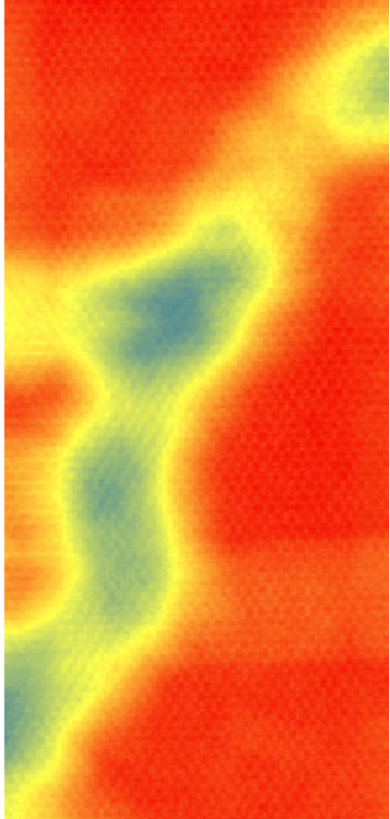
Figure 8: Tree density in trees/hectare (red: higher density, green: lower